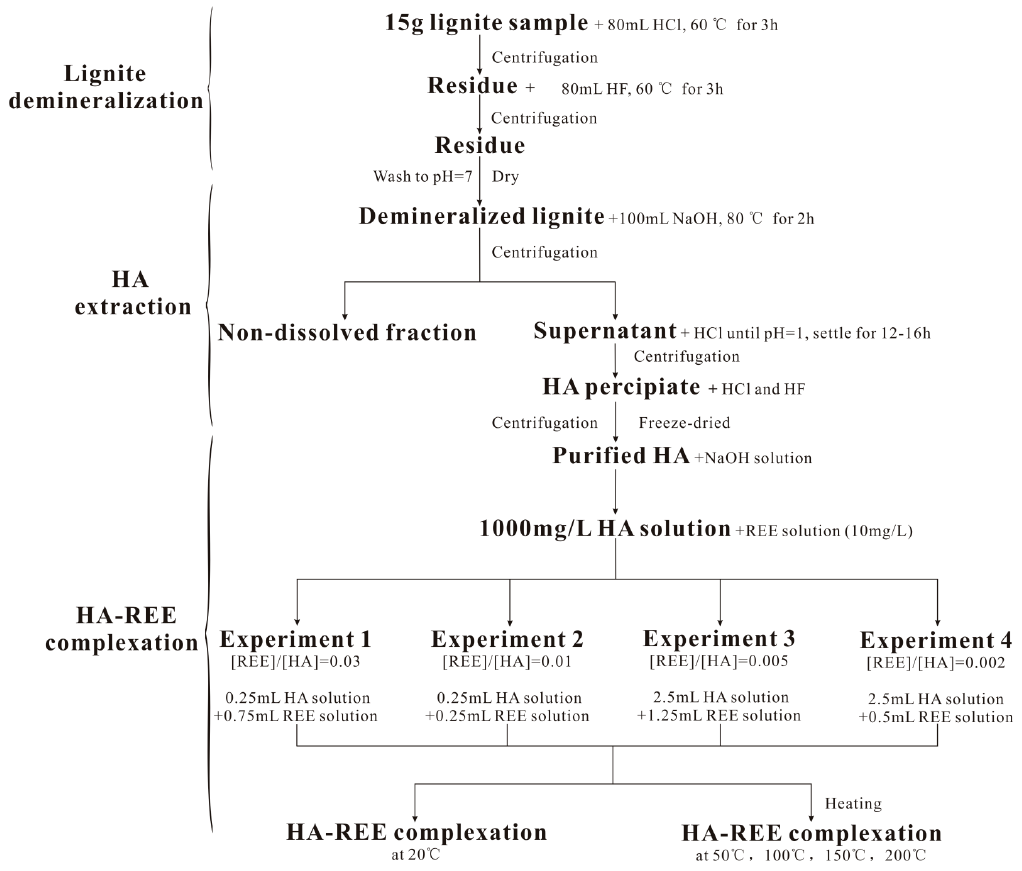
Figure 1. Diagram showing the lignite demineralization, HA extraction, and HA–REE complexation procedures.